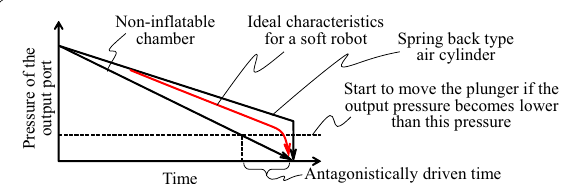
SMC CJ2KM16-60TZ